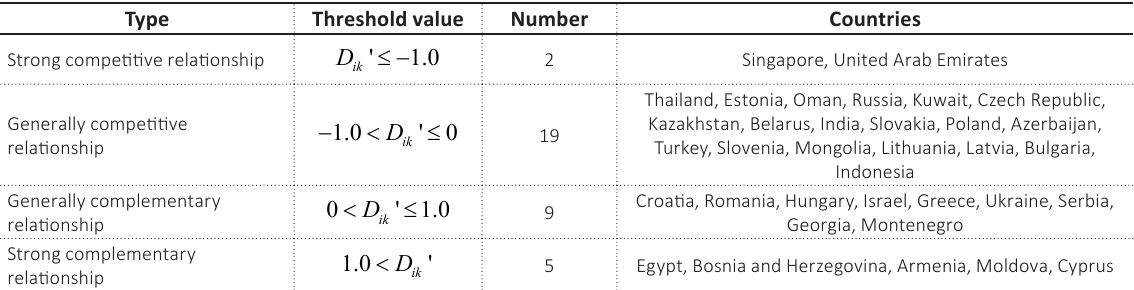
Figure 1. The evolution of geo-economic relationships of China’s sporting goods industry with those of the BRI countries from 2013 to Table 3. Types of geo-economic relations between the sporting goods industry in China and those in the BRI countries